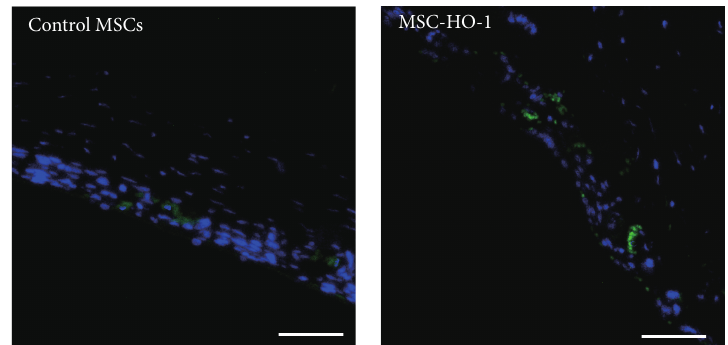
Figure 8: Survival of transplanted MSC in rat retina. After transplantation for 21 days, the survival of transplanted MSC was examined based on the expression of GFP. Bar = 50 𝜇